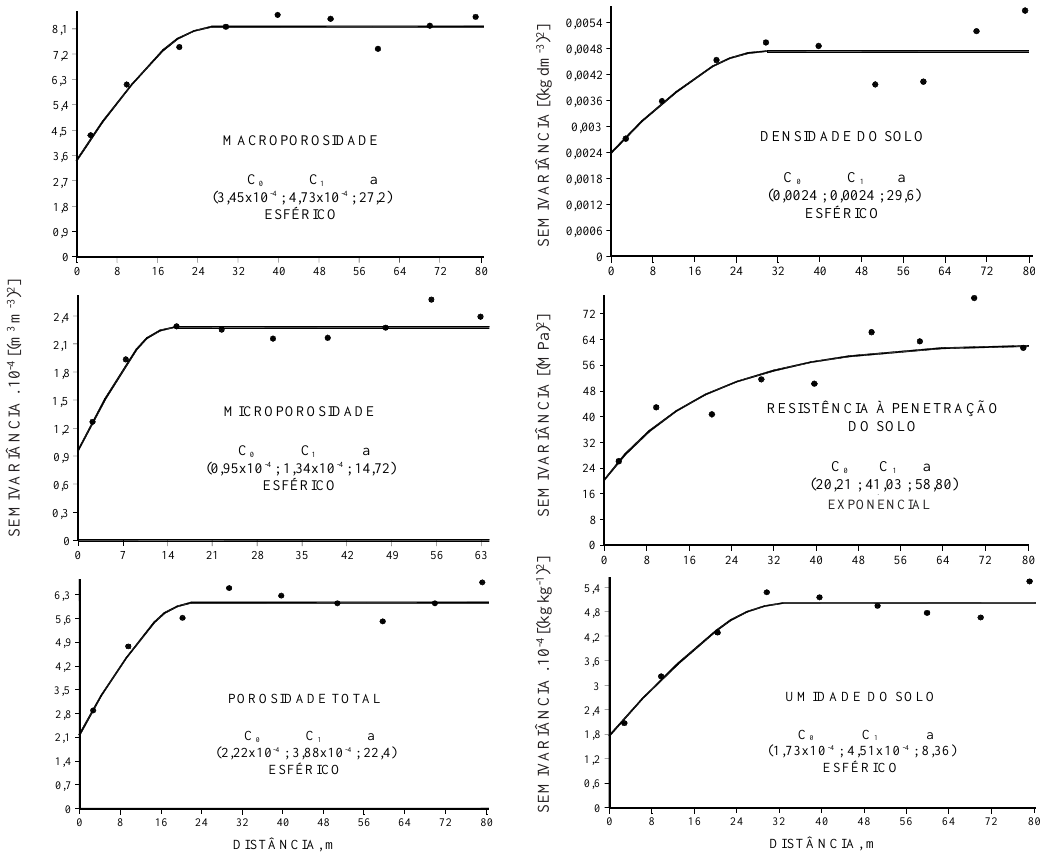
Figura 2. Semivariogramas dos atributos: macroporosidade, microporosidade, porosidade total, densidade do solo, resistência à penetração do solo e umidade do solo na profundidade e 0,15-0,20 m, em um Latossolo Vermelho